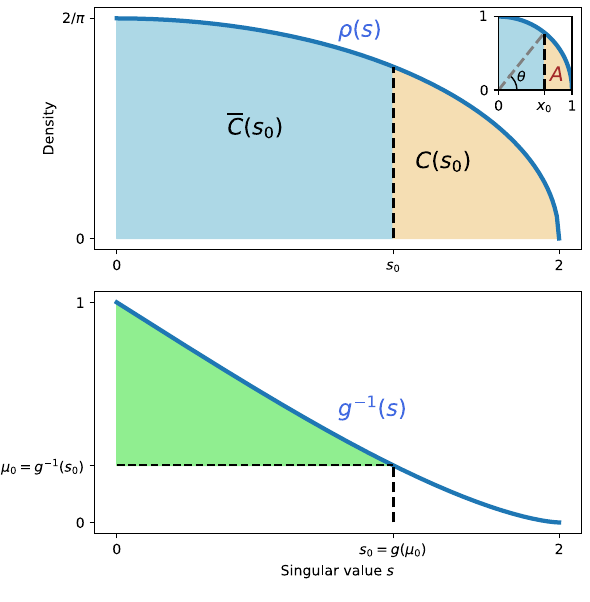
FIG. 15. Quadrant law (upper panel) and dispersion of the singular values (lower